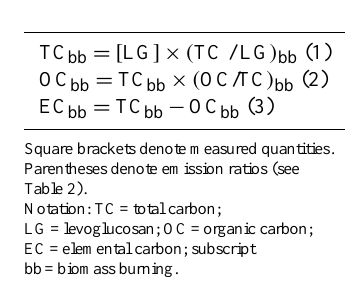
Table 1. Equations used to calculate concentrations of EC bb .